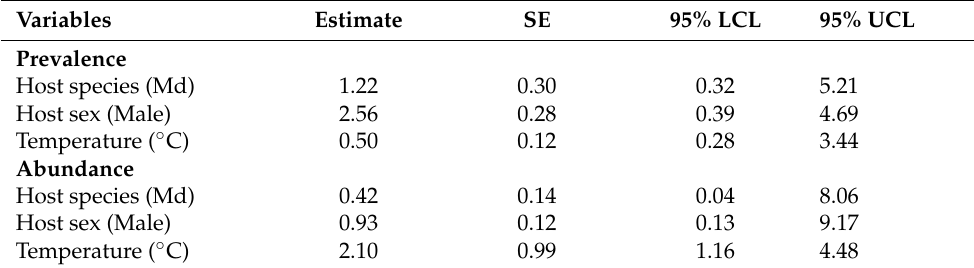
Table 3. Summary of best model describing the ectoparasite abundance (zero-inflated negative binomial) and prevalence (binomial and logitlink function) of the rodents M. delectorum and R. dilectus on Mount Meru, Tanzania. For categorical variables, the reference level is reported in